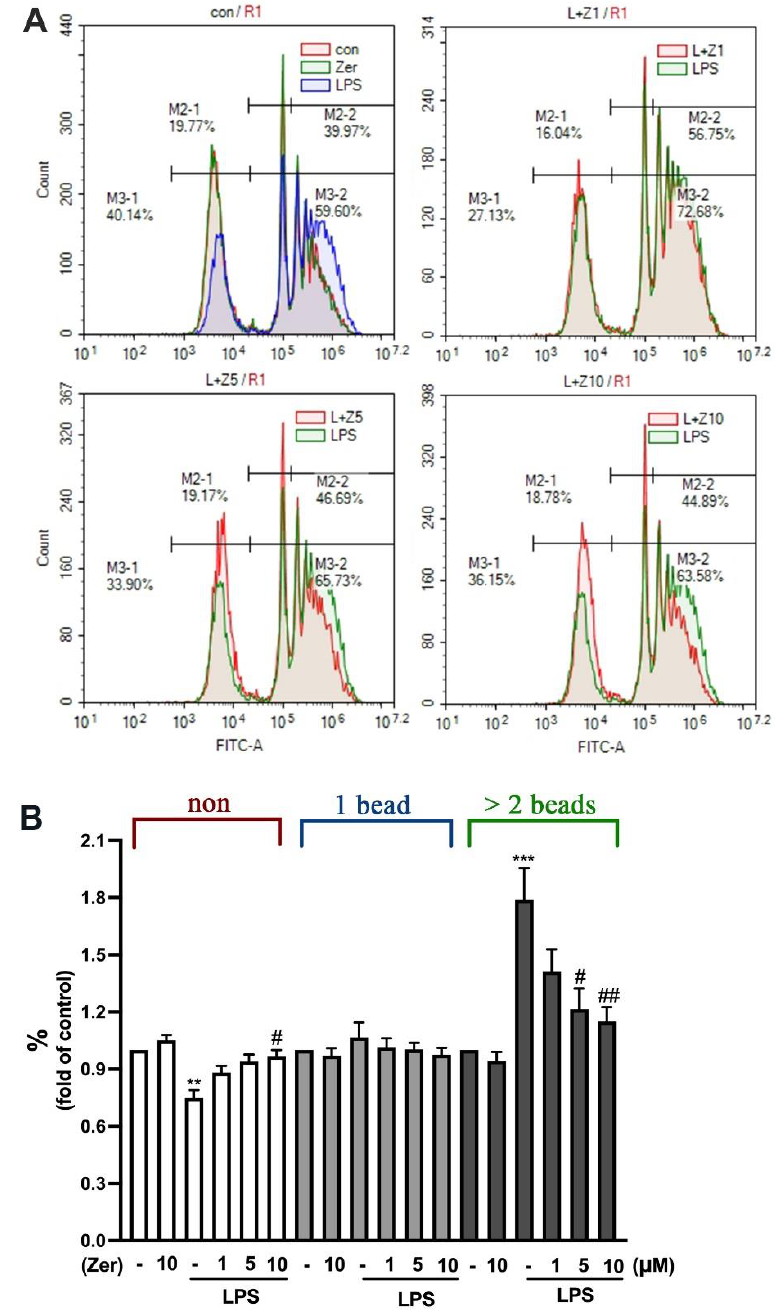
Figure 3. Effect of zerumbone on phagocytic ability in microglia. ( A ) IMG cells were presupple- mented with different concentrations of zerumbone (1, 5, or 10 μM) for 30 min and LPS (50 ng/mL) for another 24 h. After incubation of the cells with 1 μm fluorescent YG beads for 1 h at 37 °C, the intensity of the beads was analyzed using flow cytometry. The quantitative results shown in ( B ) are the mean ± SEM ( n = 4): non, no bead was uptaken by cell; 1 bead, cell uptake 1 bead; >2 beads, cell uptake more than 2 beads. ** p < 0.01, *** p < 0.005 compared with the control group. # p < 0.05, ## p < 0.01 compared with the LPS alone group.